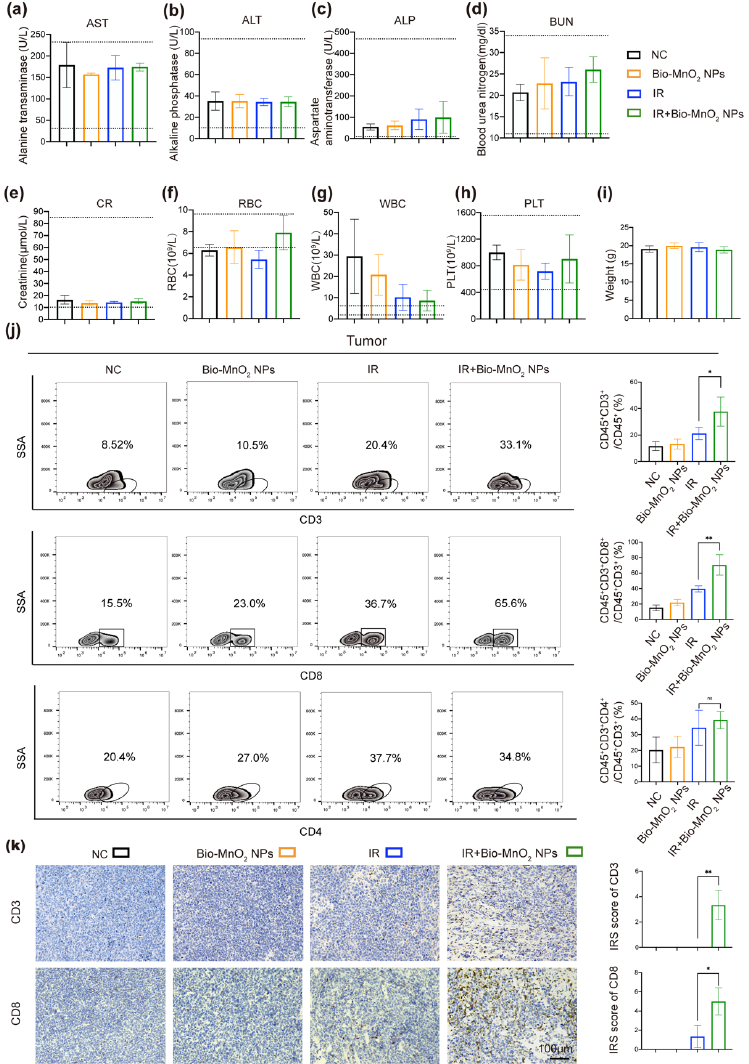
Figure 8. Bio-MnO 2 NPs plus radiation activated immune responses in vivo. ( a – e ) Comparison of liver (ALT, AST, ALP) and kidney function (BUN, CR) in different groups. ( f – h ) Comparison of the blood routine (RBC, WBC, PLT) in different groups. ( i ) Body weight of the mice when the mice reached the welfare end point. ( j ) Flow cytometry of CD45 + CD3 + , CD45 + CD3 + CD8 + and CD45 + CD3 + CD4 + T cells in tumor tissues. ( k ) Representative images and statistical graphs of CD3, CD8 staining in tumors tissues. ns, no significance; *, p < 0.05; **, p < 0.01. Given the ability of Bio-MnO 2 NPs to activate cGAS-STING pathway in vitro that is crucial for immunotherapy, we verified whether Bio-MnO 2 NPs could also enhance